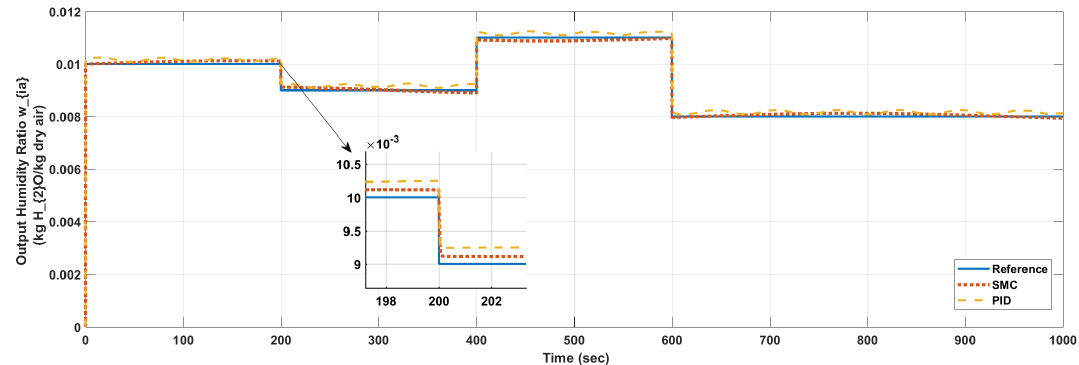
Figure 6. Output humidity response of controllers while tracking sequence of steps reference.